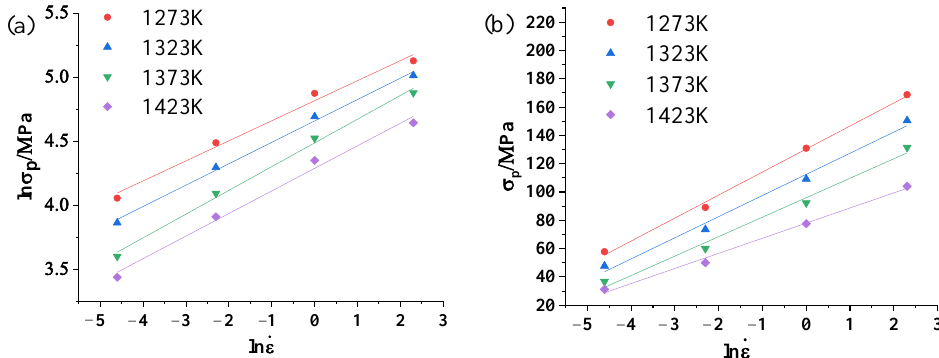
. ε —ln σ p and   ln —ln  p